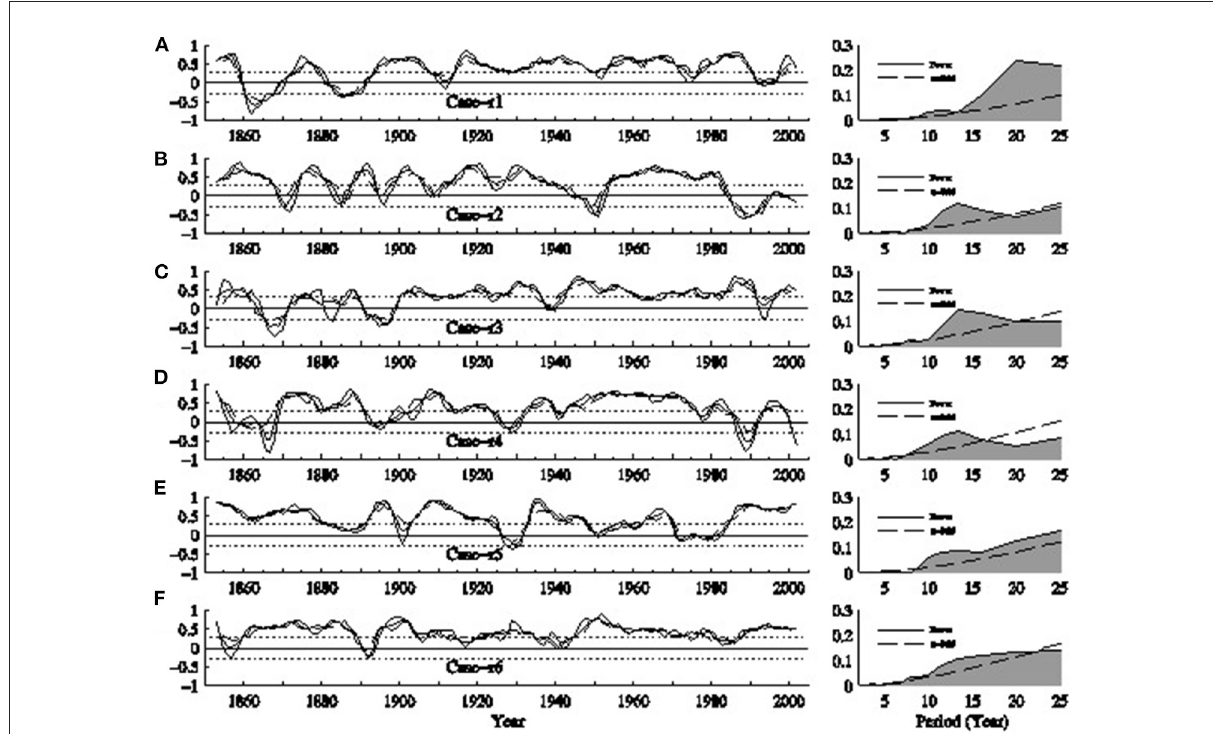
FIGURE2 Decadal variability of the IOD-ENSO lag correlations in CCSM4 simulations (all six ensemble experiments). The lag correlations between the SSTA in STIO in fall and the Niño3.4 indices in the following fall are calculated in all six historical ensemble cases (A–F) in 7-year (solid curve), 9-year (dash curve), and 11-year (dash dot curve) sliding windows. Horizontal dashed lines indicate the positive and negative phases (positive lag correlations above the upper dashed line and negative phased under the lower dashed line). The right column shows the power spectra of the lag correlations in the 7 years sliding window with statistics calculated based on all the six ensemble experiments. Dash curves indicate 95% confidence level based on the Student’s- t test.